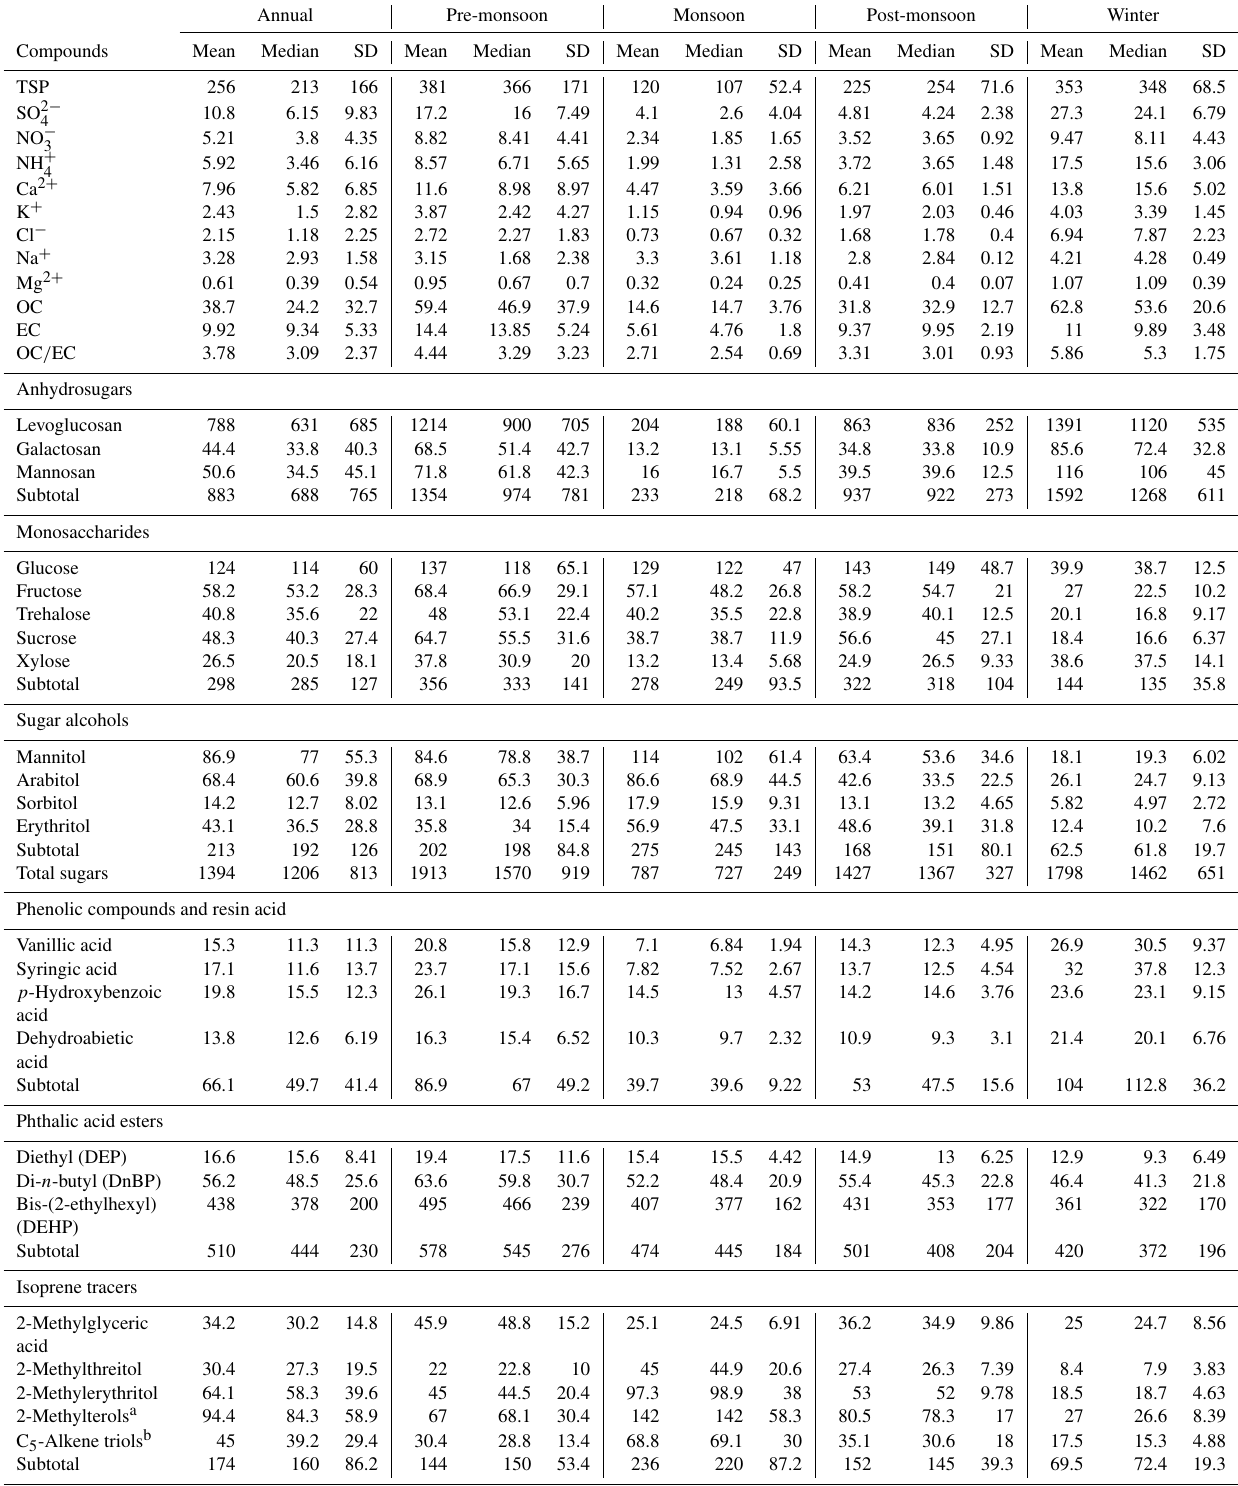
Table 1. Concentrations of TSP, major ions, OC, EC (µgm − 3 ), and molecular tracers in the aerosols from Bode, Kathmandu Valley (ngm − 3 ). Annual Pre-monsoon Monsoon Post-monsoon Winter